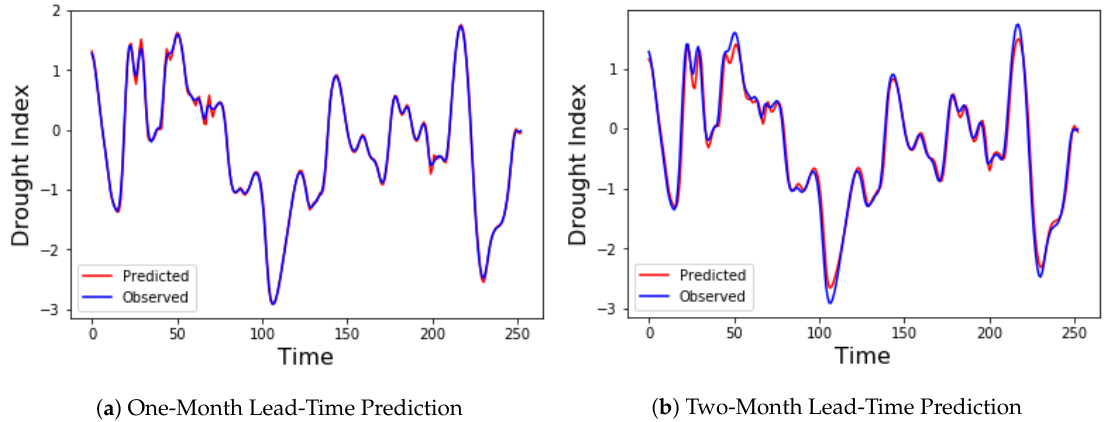
Figure 13. Observed and predicted drought Index using the EMD-DBN model for Lee’s Ferry Station.